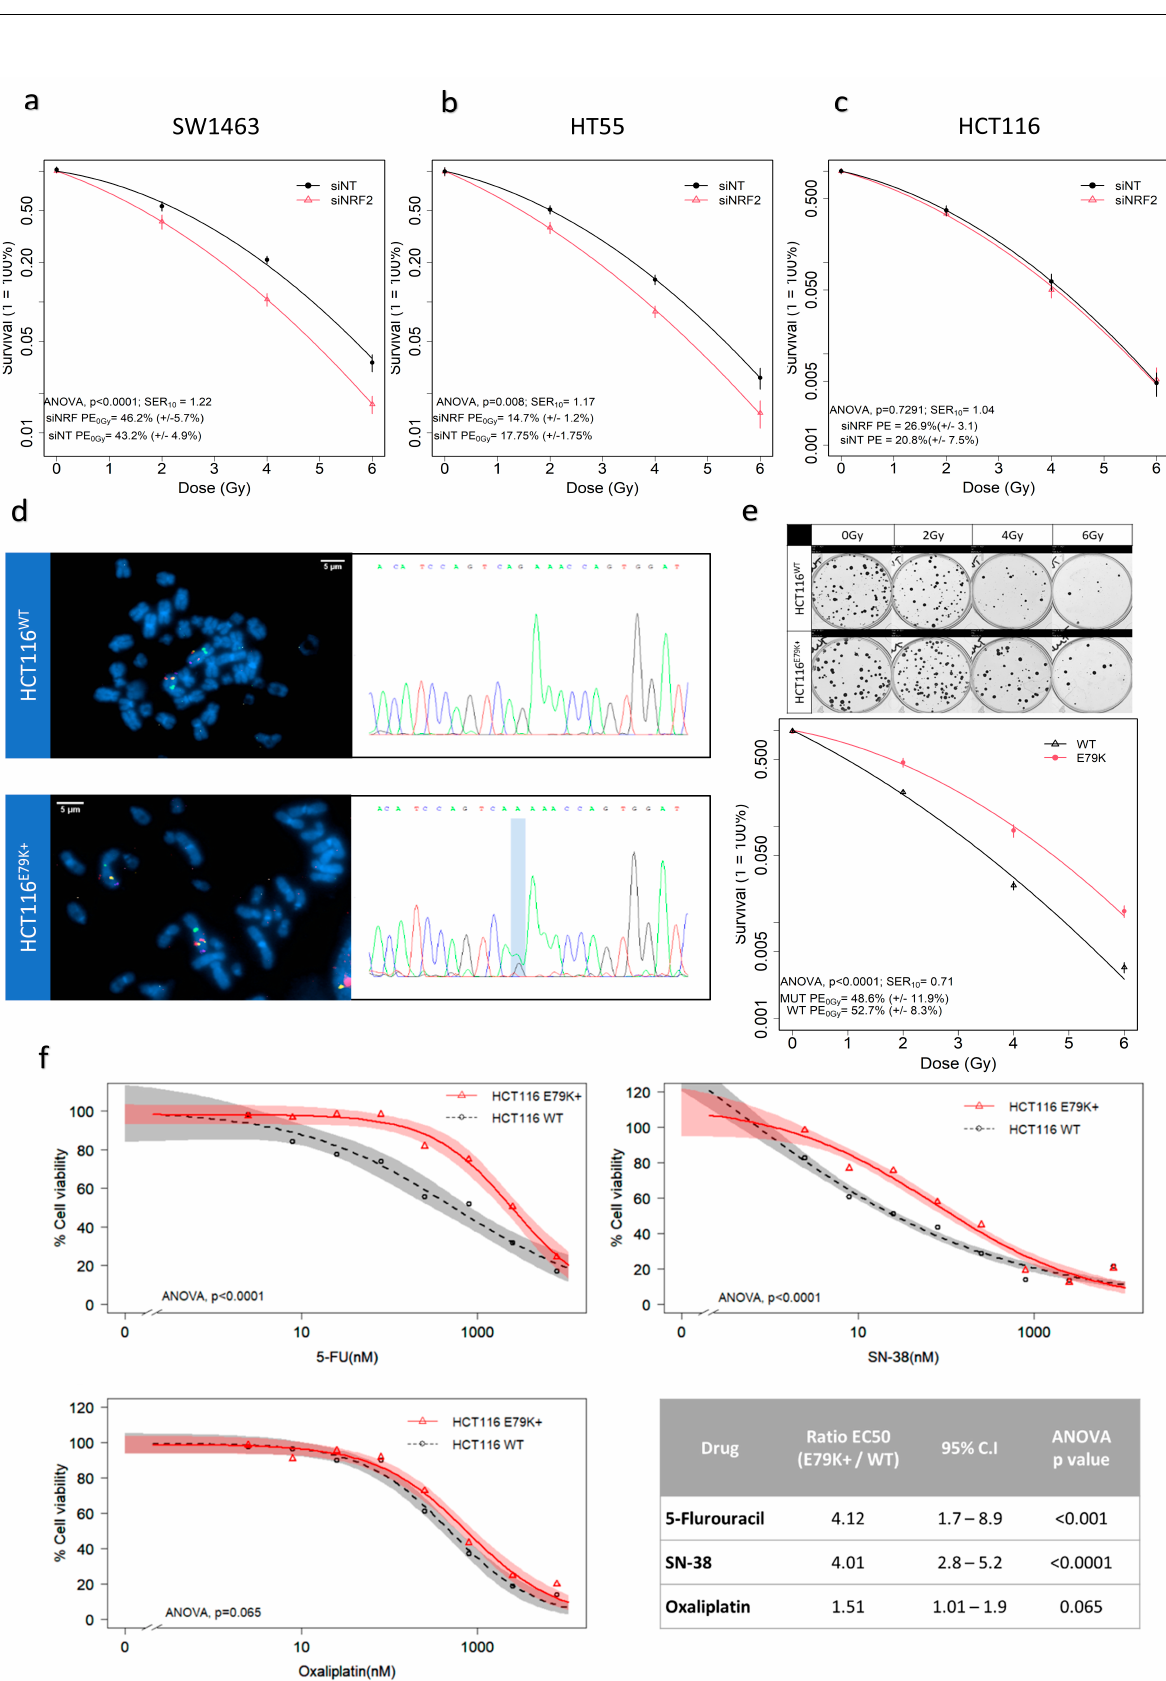
Figure 1. NRF2 knockdown increases radiosensitivity in resistant cell lines and introduction of NRF2 mutation induces radioresistance in sensitive cells. ( a – c ) Cell survival curves demonstrating significant radiosensitisation in SW1463 and HT55, but not HCT116; ( d ) FISH analysis of NFE2L2 locus and Sanger sequencing of CRISPR HCT116 isogenic cell lines